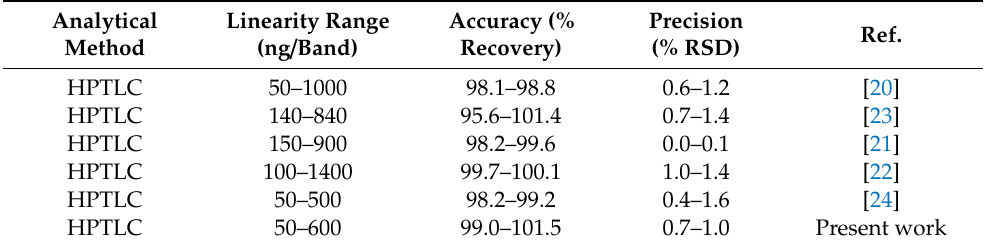
Table 6. Comparison of the current green RP-HPTLC method with reported HPTLC methods for the determination of